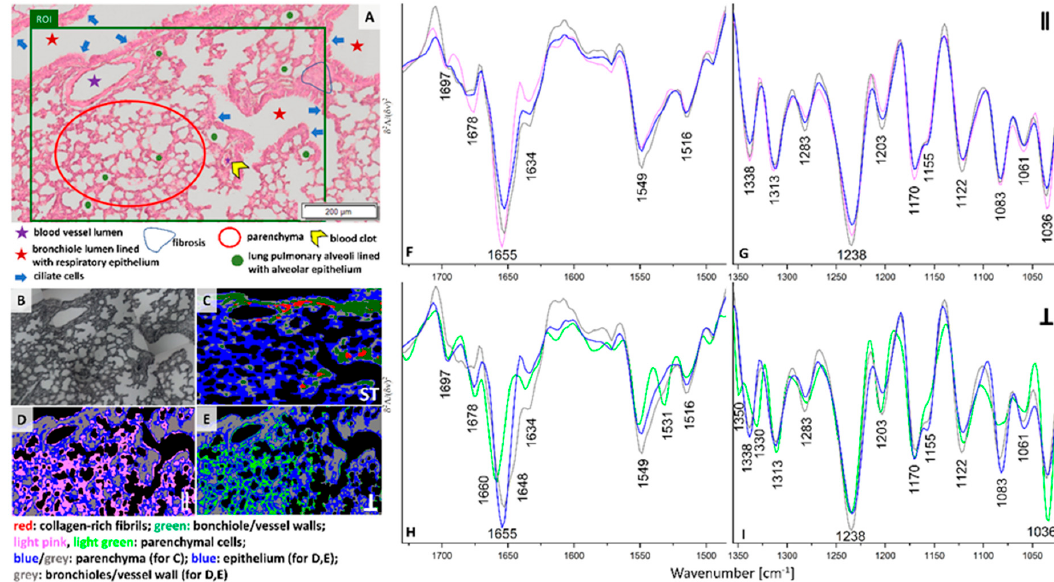
Figure 3. ( A ) A H&E micro-photography showing cellular phenotypes of lung parenchyma observed in the micro-metastasis phase (week 3) and ROI (green area) imaged spectroscopically (magnification: 20 × ); ( B ) a white-field image of the ROI (magnification: 15 × ); false-colour UHCA maps for IR images recorded by using non-polarized FTIR imaging ( C ), 0 ◦ ( D ) and 90 ◦ ( E ) polarization contrast imaging. Mean second derivative FTIR spectra extracted from UHCA maps for 0 ◦ ( F , G ) and 90 ◦ ( H , I ) polarized IR light. Mean spectra of non-polarized FTIR imaging are collected in Figure S3I,J. The colors of classes correspond to the colors of the spectra.